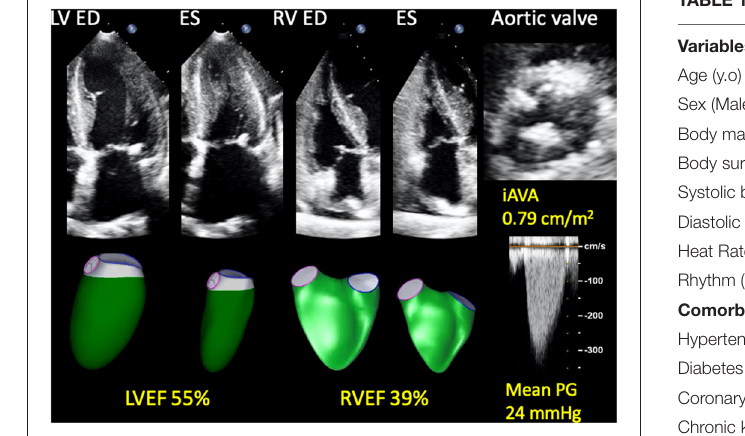
FIGURE 1 | Representative 3D RV and LV analyses in a patient with asymptomatic AS who developed a cardiac event. A 74-year-old woman who developed heart failure three months after baseline echocardiography. AS was moderate and LVEF was preserved; however, RVEF was reduced. She also had hypertension, chronic kidney disease, and chronic obstructive pulmonary disease. 3D, three-dimensional; AS, aortic stenosis; ED, end-diastole; ES, end-systole; iAVA, indexed aortic valve area; LV, left ventricular; LVEF, left ventricular ejection fraction; PG, pressure gradient; RV, right ventricular; RVEF, right ventricular ejection fraction.